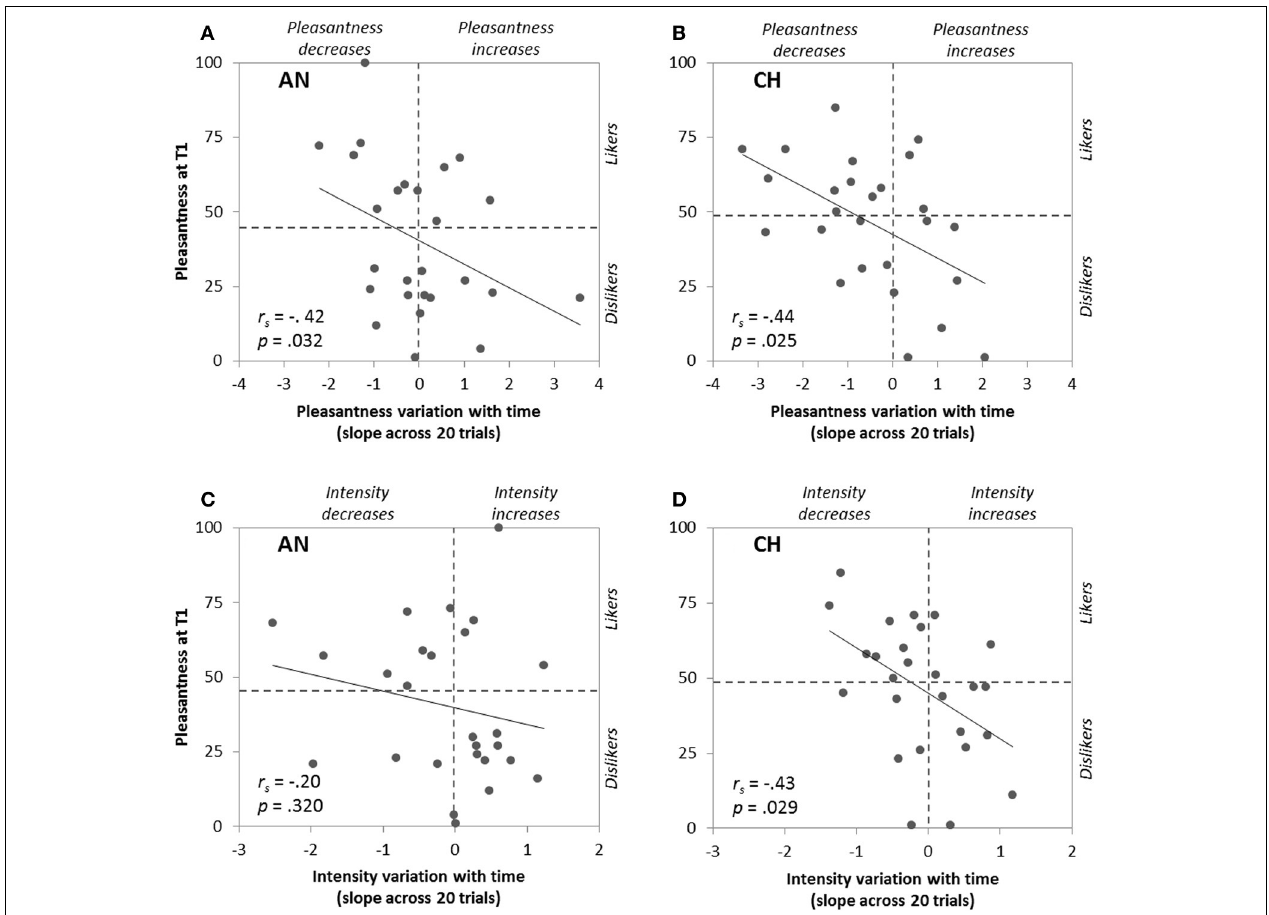
FIGURE 3 | Correlations between pleasantness ratings at T1 (first odor presentation) and time-related changes of pleasantness (A,B) and intensity (C,D) ratings represented by their slopes across the 20 odor presentations, for anise (AN) and chocolate